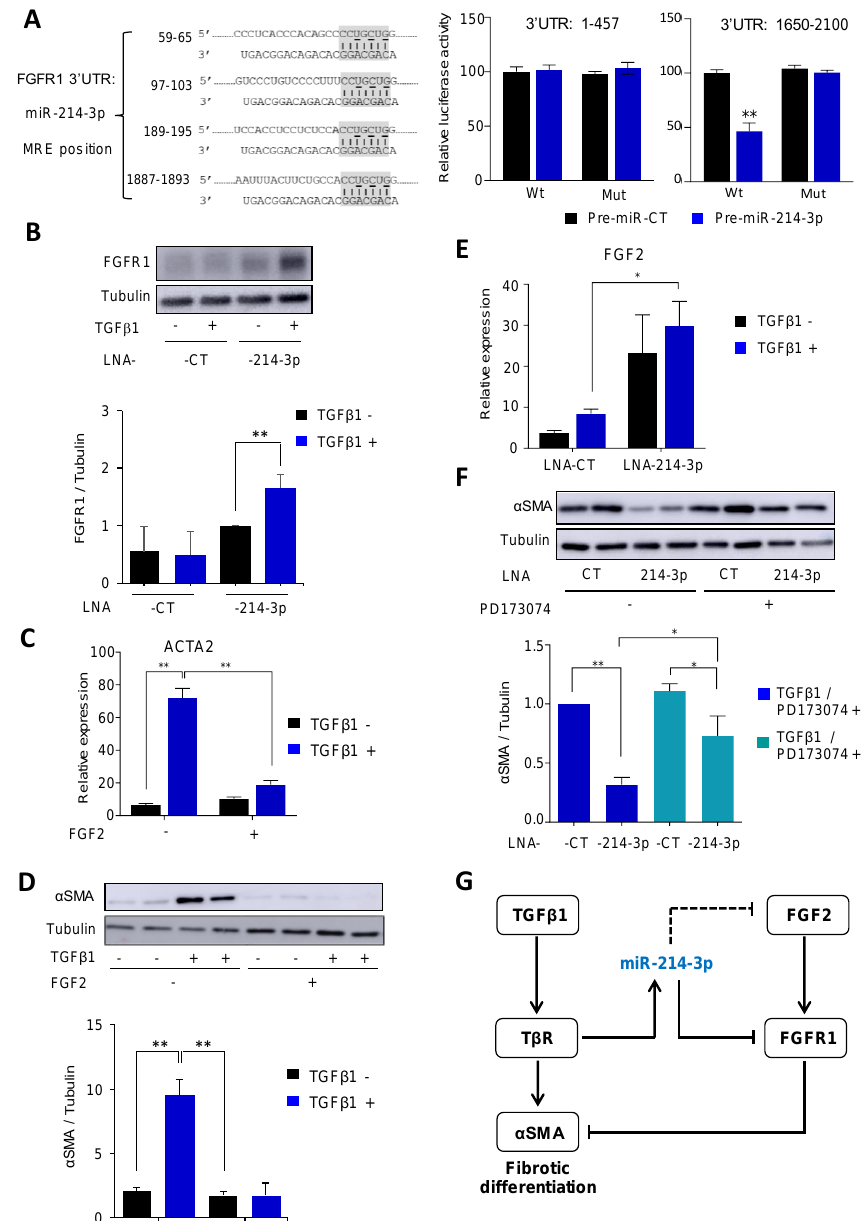
Figure 4. miR-214-3p mediates TGFβ1-induced FAP activation by targeting FGFR pathway. ( A ) Position of miR-214-3p putative target site on FGFR1 3′UTR from TargetScan (19). The seed region of miR-214-3p is highlighted in grey and complementarities are indicated. Bases that were mutated in psiCHECK-2 constructs (MUT) are underlined. Pre-miR-214-3p or control Pre-miR-CT and hFGFR1 3′UTR (from base 1 to base 457 and from base 1650 to base 2100)-derived psiCHECK-2 constructs were transfected in HEK293 cells. All Renilla luciferase activities were normalized with firefly luciferase activity. ( n = 3). ** p < 0.01. ( B ) FGFR1 protein was detected by immunoblot in FAPs transfected with LNA CT or LNA-214-3p and then stimulated—or not—with TGF β 1 for 2 days. Tubulin was used as loading control. One of three independent replicates is shown. Quantification is shown as mean ± SEM. ** p < 0.01. ( C ) ACTA2 mRNA expression was measured by quantitative RT-PCR in FAPs co-stimulated by TGF β 1 (5 ng/mL) and FGF2 (10 ng/mL)—or not. TBP was used as housekeeping gene. Experiments were performed on three distinct biopsies. Data are expressed as mean ± SEM. ** p < 0.01. ( D ) α SMA was detected by immunoblot in FAPs stimulated with the FGFR inhibitor PD173074 at 75 nM for 10 min and then transfected with LNA-CT or LNA-214-3p for 24 h before the differentiation phase in fibrogenic condition induced by 1.5 ng/mL of TGF β 1 for 2 days. Tubulin was used as loading control. One of three independent replicates is shown. Quantification is shown as mean ± SEM. ** p < 0.01. ( E ) FGF2 mRNA expression was measured by quantitative RT-PCR in FAPs,